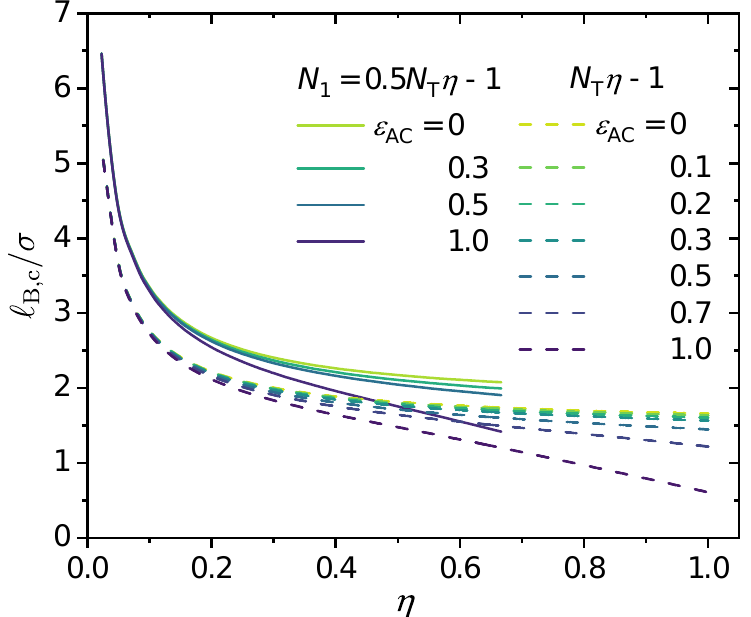
Figure 12. Bjerrum length of critical points (cid:96) B,c in the binodal curves. The values for the following parameters were fixed: (cid:101) A = (cid:101) B = 0, Z A = − 1, Z C = − 2, N T = 10 5 . Values for η were varied under different (cid:101) AC and N 1